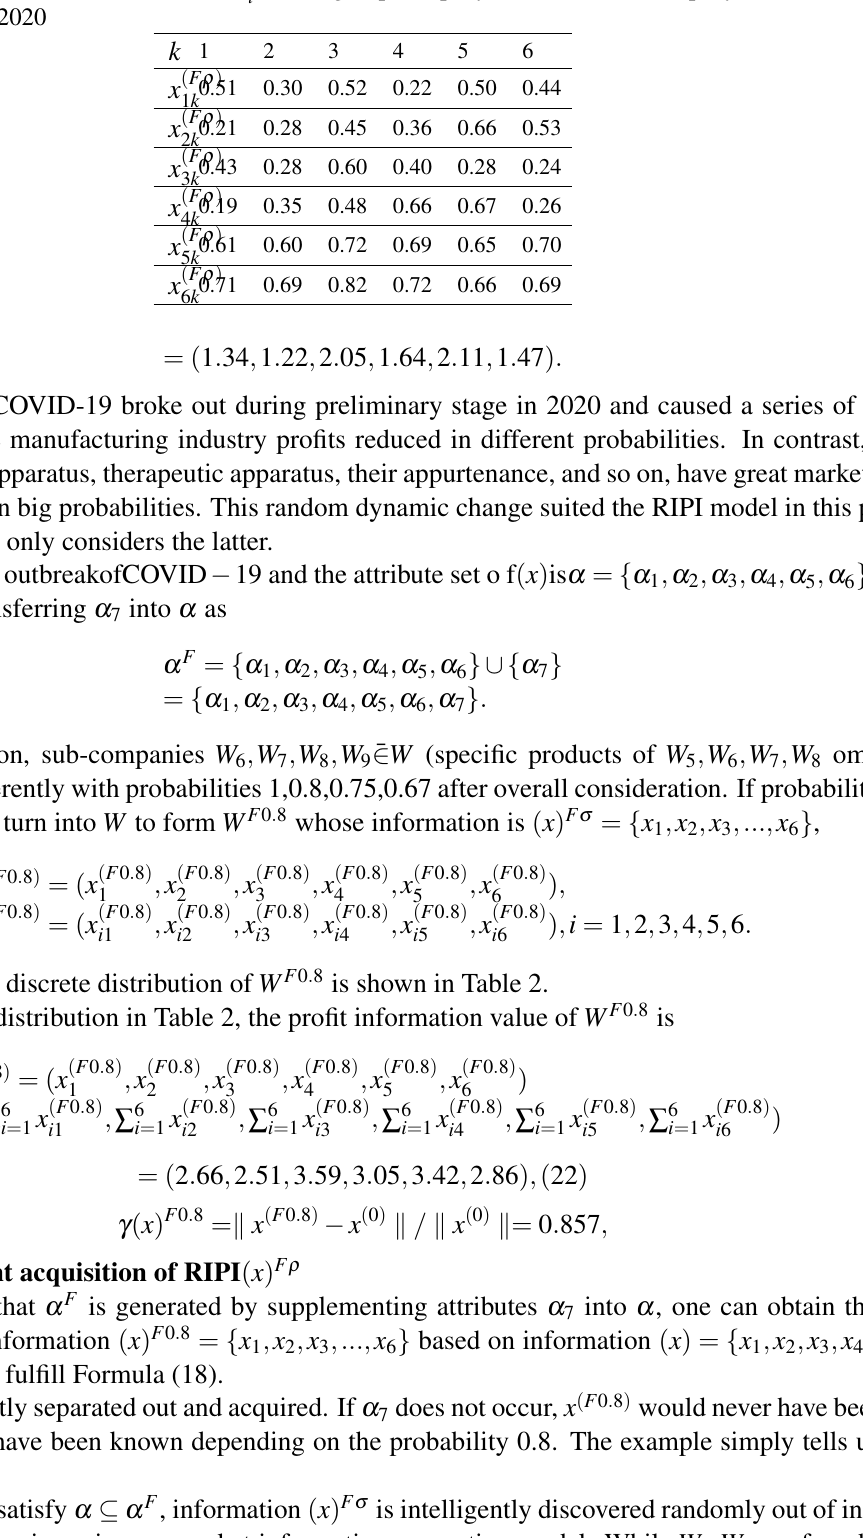
Table 2 The profit discrete distributions x ( F 0 . 8 ) , x ( F 0 . 8 )